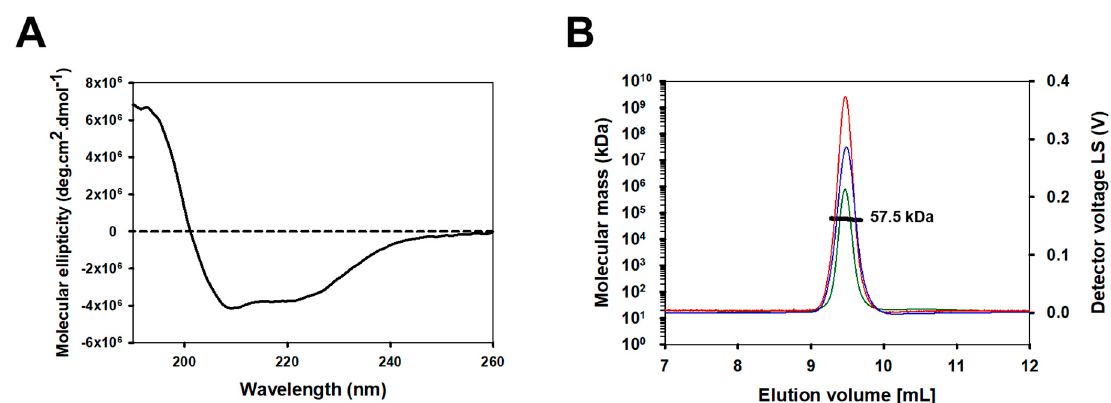
Figure 3. Secondary structure and oligomerization analysis of the purified hTAS1R2-VFT. Size exclusion chromatography of purified hTAS1R2-VFT. ( A ) The far-UV circular dichroism spectrum of hTAS1R2-VFT, recorded with 50 mM Tris-HCl pH 8, 150 mM NaCl, 0.5 mM DDM and 1 mM DTT, shows that there is a high content of α -helical secondary structures. Protein concentration—1 mg/mL. Light path—0.01 cm. ( B ) For SEC-MALS analysis, purified hTAS1R2-VFT was injected into a Superdex 200 10/300, 24 mL column (GE Healthcare) and eluted with 50 mM Tris-HCl pH 8, 150 mM NaCl, and 0.5 mM DDM. The chromatograms show the calculated molecular mass (bold black curve), differential refractive index dRI (blue curve), light scattering (red curve) and UV at 280 nm (green curve). hTAS1R2-VFT has a fitted molecular mass of 57.5 kDa; its theoretical monomer molecular mass value is 57.0